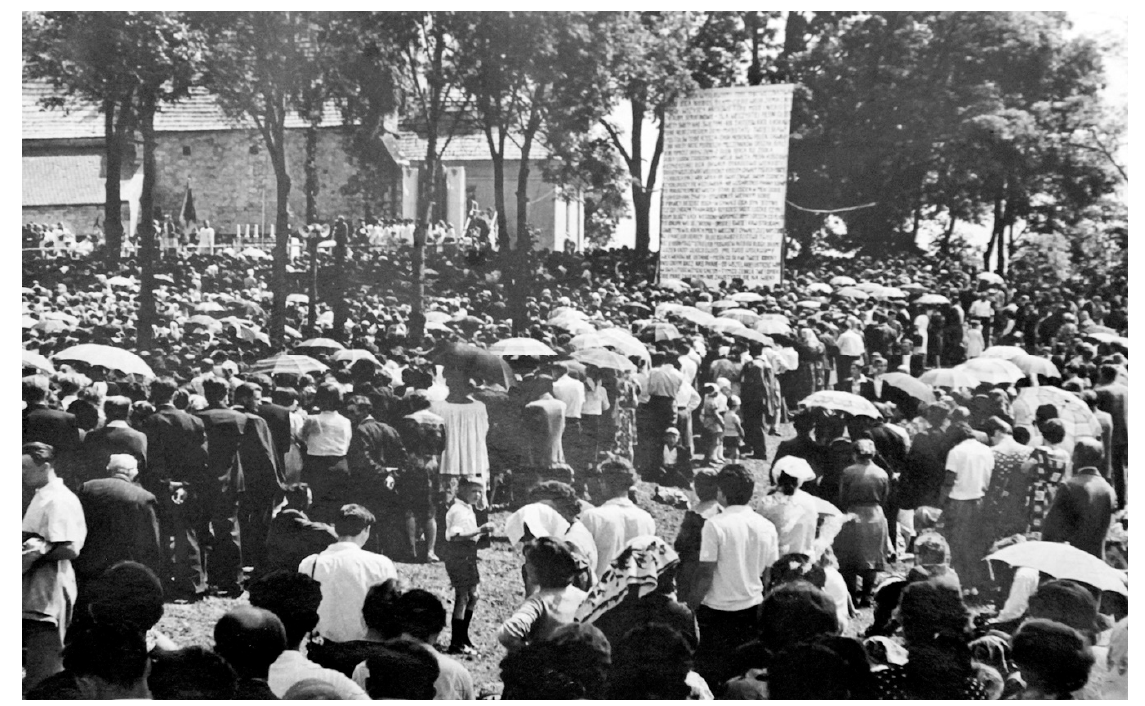
Figure 4. Celebrations of the coronation of the figure of the Mother of God of Wi ś lica (17 July 1966) (photo: Archives of the Sanctuary of Mother of God of Wi ś lica in Wi ś lica).